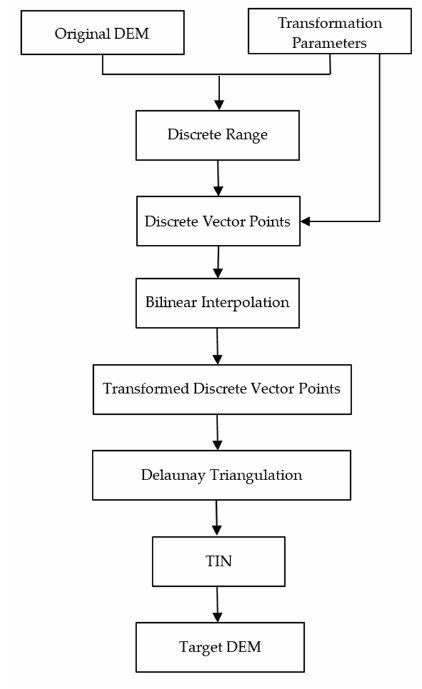
transformation parameters of source and target DEM. Figure 3c is the relative position corresponding to source and target blocks. (∆x, ∆y) are parameters from source to target coordinate transformation. Contrarily, (∆x',∆y' ) are the parameters from target to source.